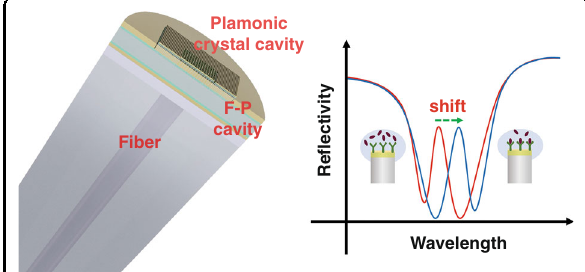
Fig. 1 A quasi-3D plasmonic-dielectric hybrid cavity on a single-mode optical fifi ber ’ s end-facet (left) and using its Fano resonance for high signal-to-noise ratio biosensing